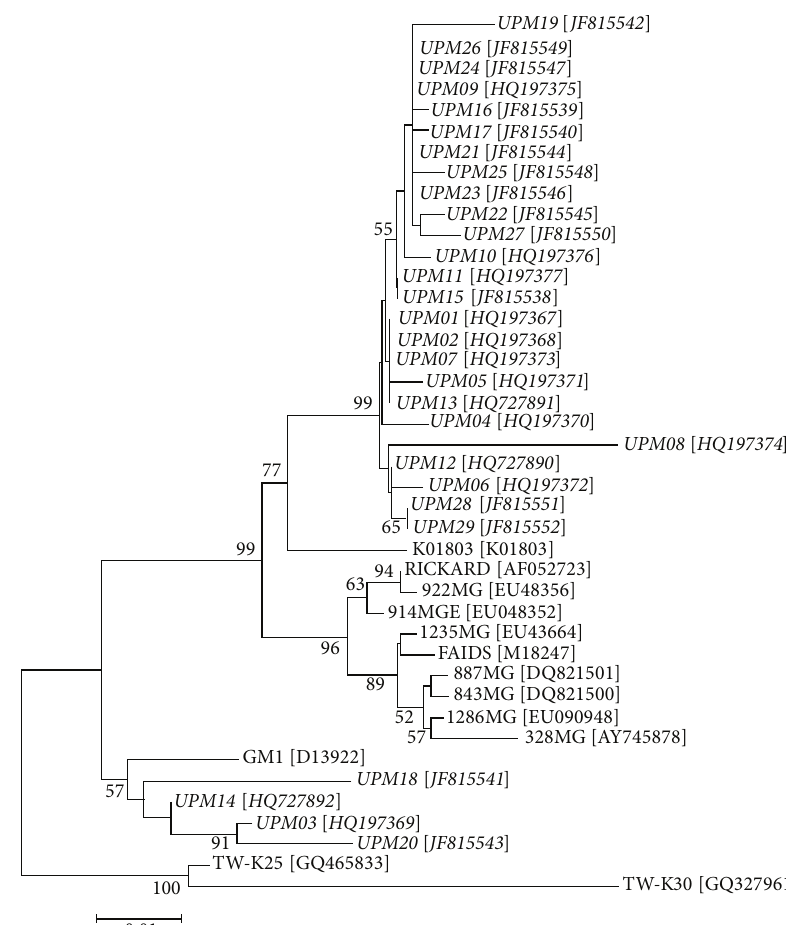
Figure 2: Neighbour-joining phylogenetic relationship of Malaysian FeLV isolates. The percentage of replicate trees in which the associated taxa clustered together in the bootstrap test (100 replicates) is shown next to the branches. Malaysian FeLV isolates are indicated in italic. Evolutionary analyses were conducted in